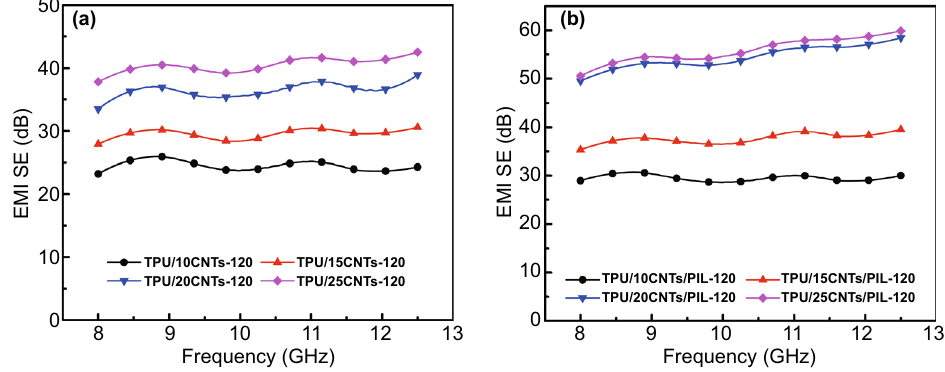
Fig. 6 EMI SE of TPU/CNTs and TPU/CNTs/PIL composite foams with various filler concentrations and an evaporate time of 120